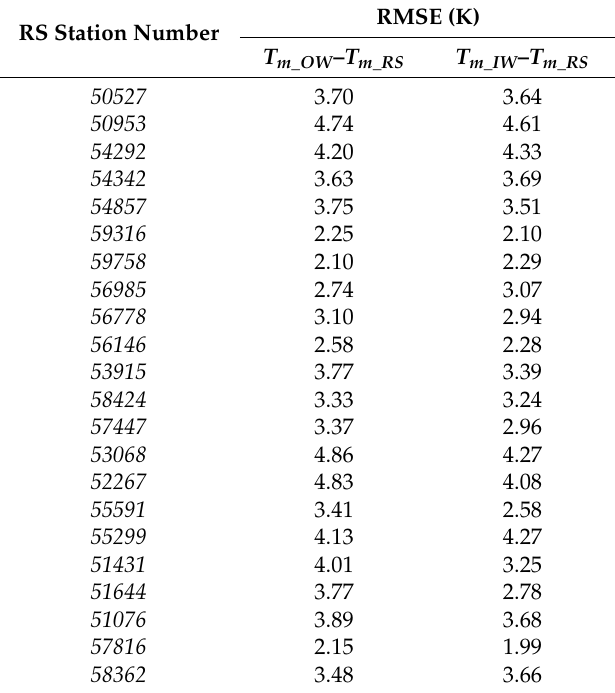
Table 4. RMSE between the T m results from three different approaches.